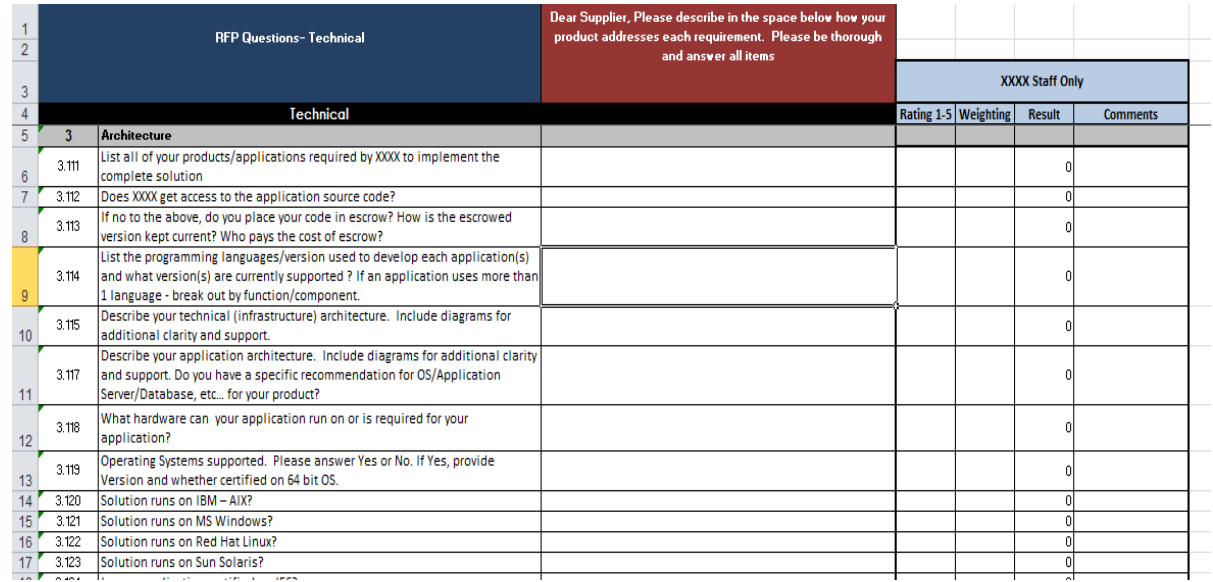
Figure 1. Excerpt from the technical section of a Request for Proposal